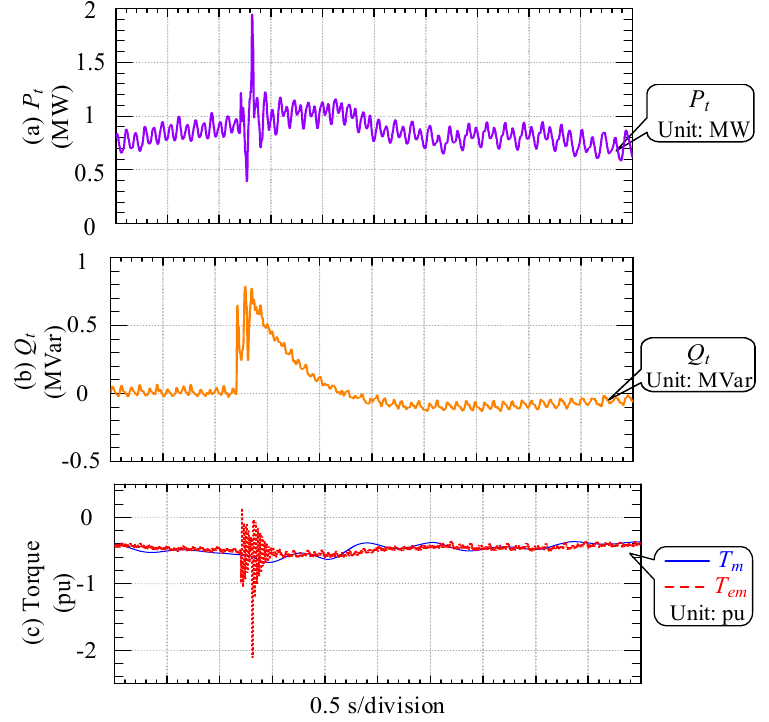
Figure 18. ( a ) Output active power P t ; ( b ) output reactive power Q t ; and ( c ) the mechanical torque T m and electromagnetic torque T em with wind speed fluctuation.